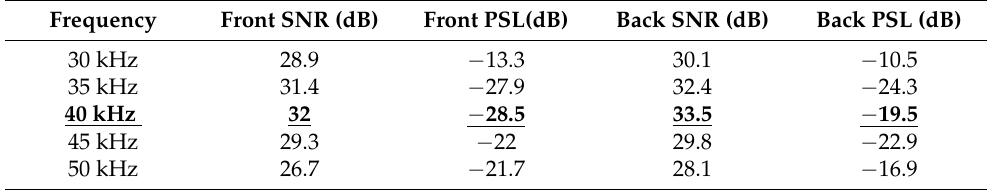
Table 4. The SNR and PSL of b3g4 code from FE and BE at different